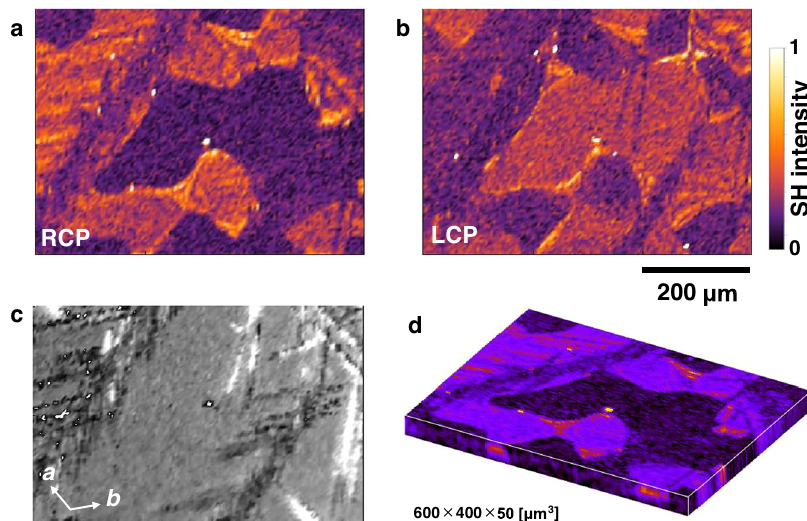
Fig. 2 SHG imaging of ferroaxial domains in NiTiO 3 using circularly polarized fundamental light. a , b Two-dimensional maps of SH intensity obtained with ( a ) right-handed circularly polarized (RCP) and ( b ) left-handed circularly polarized (LCP) light. Bright and dark regions correspond to either A + or A − ferroaxial domains. c Transmission optical microscopy image of the area corresponding to the SHG images of ( a ) and ( b ). Branch-like patterns in ( c ) correspond to TiO 2 impurities. d Three-dimensional image of SH intensity at the same area as ( a ) and ( b